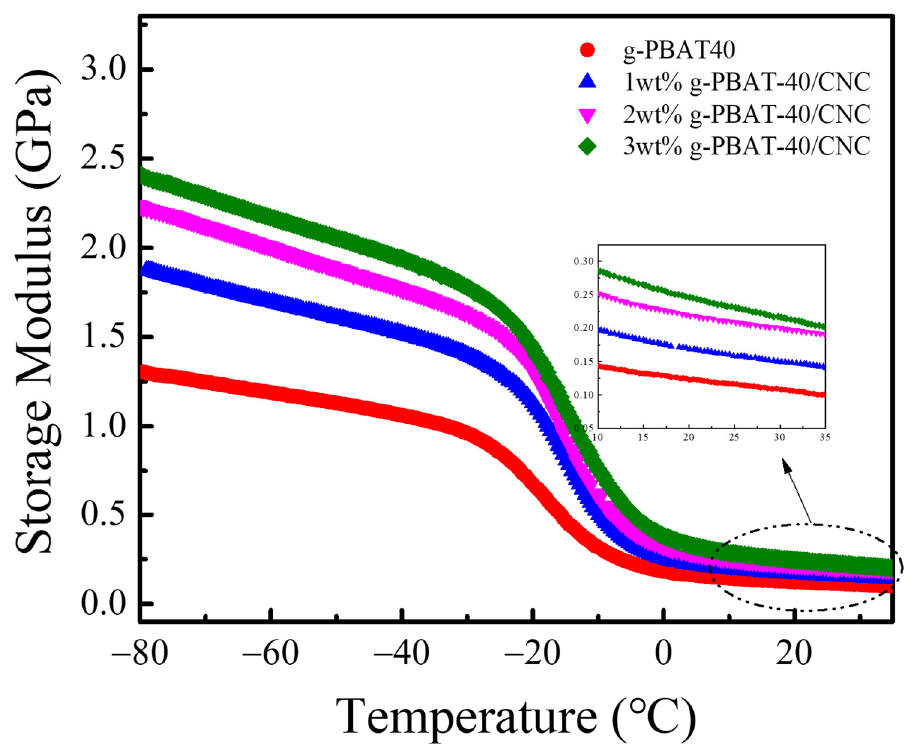
Figure 10. Dependence of the storage modulus on temperature of PBAT-40 and g-PBAT-40/CNC nanocomposites.